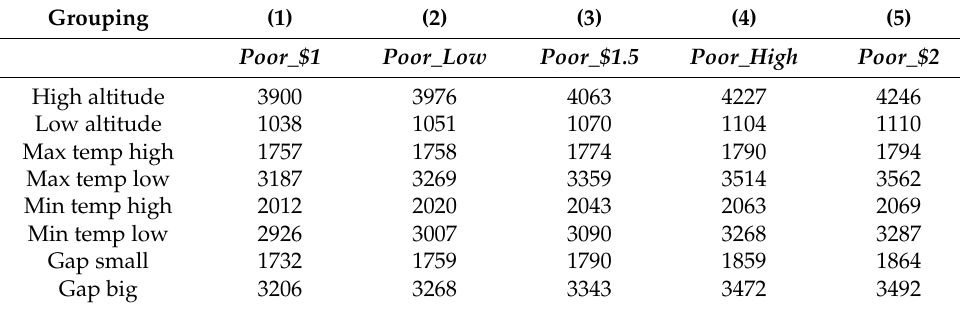
Table 3. Group descriptive statistical